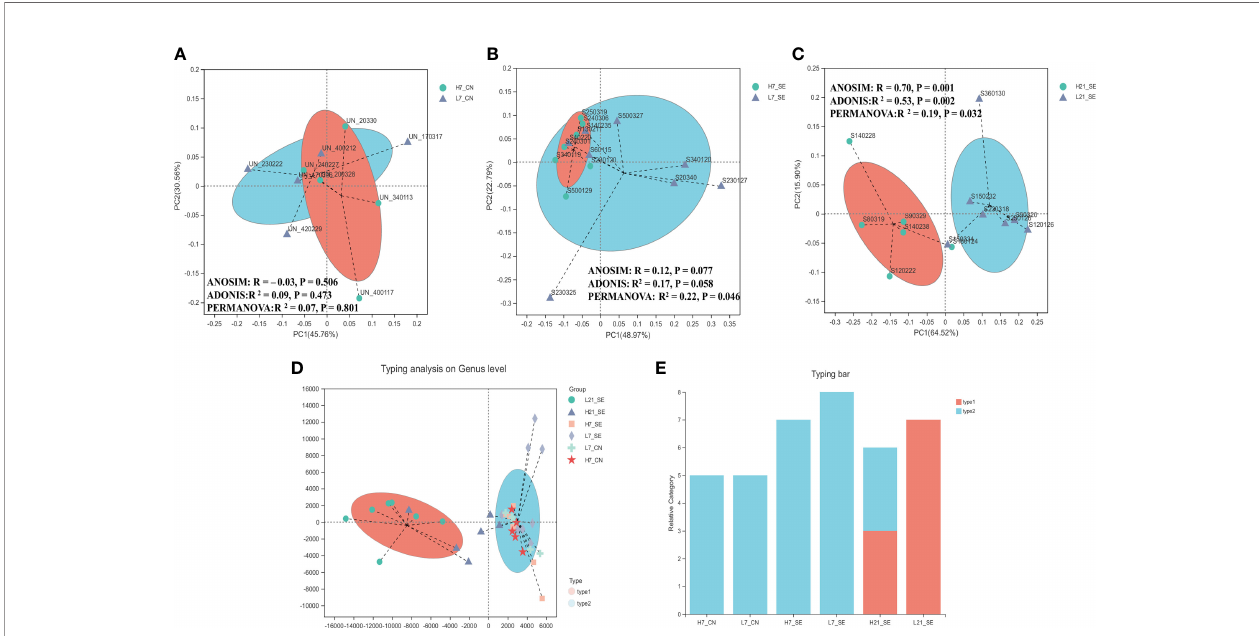
FIGURE 4 | Comparison analysis of cecum microbiota pro fi le of non-infected SE-infected high and low H/L chickens. (A) Beta diversity, Principal coordinates analysis (PCoA) performed with weighted UniFrac distances showed no clear separation pattern between low and high H/L ratio non-infected chickens at 7 dpi. (B) Beta diversity, Principal coordinates analysis (PCoA) performed with weighted UniFrac distances showed no clear separation pattern between low and high H/L ratio SE-infected chickens at 7 dpi. (C) beta diversity, Principal coordinates analysis (PCoA) performed with weighted UniFrac distances showed more visible separation of clustering pattern between low and high H/L ratio SE-infected chickens at 21 dpi. (D) Typing analysis on genus level showing samples clustering according dominant species. (E) Bar typing analysis showing distribution of dominant species among groups. H7_CN: high H/L non-infected 7 dpi (n = 5); L7_CN: low H/L non-infected 7 dpi (n = 5); H7_SE: High H/L SE- infected 7 dpi (n = 8); L7_SE: Low H/L SE-infected 7 dpi (n = 7); H21_SE: high H/L SE-infected 21 dpi (n = 6); L21_SE: Low H/L SE-infected 21 dpi (n =